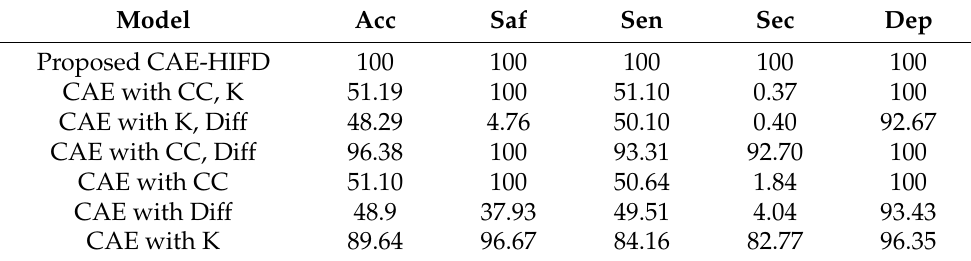
Table 2. Impact of differencing, cross-correlation, and kurtosis on CAE-HIFD